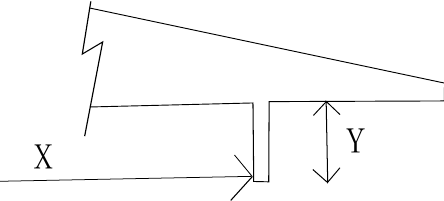
Figure 4. Location of the microtab (MT) from the airfoil leading edge X and size of the MT denoted as Y .